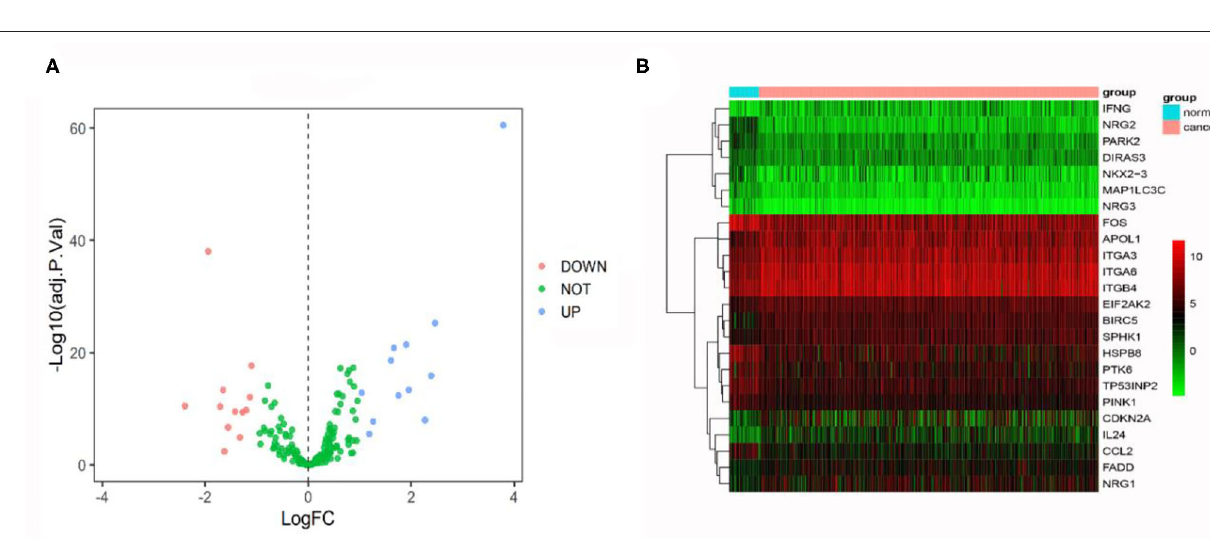
enriched terms into a network with edges connecting overlapping gene sets shows the clusters of several related genes ( Supplementary Figure 2